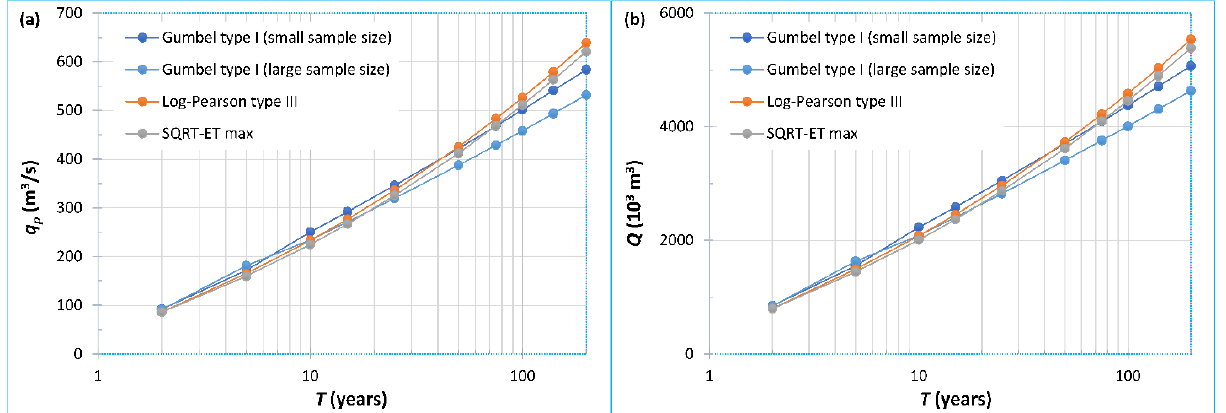
Figure 4. ( a ) Peak flow discharge ( q p ), and ( b ) runoff volume ( Q ) during return period for the probability distribution functions and for the whole basin.